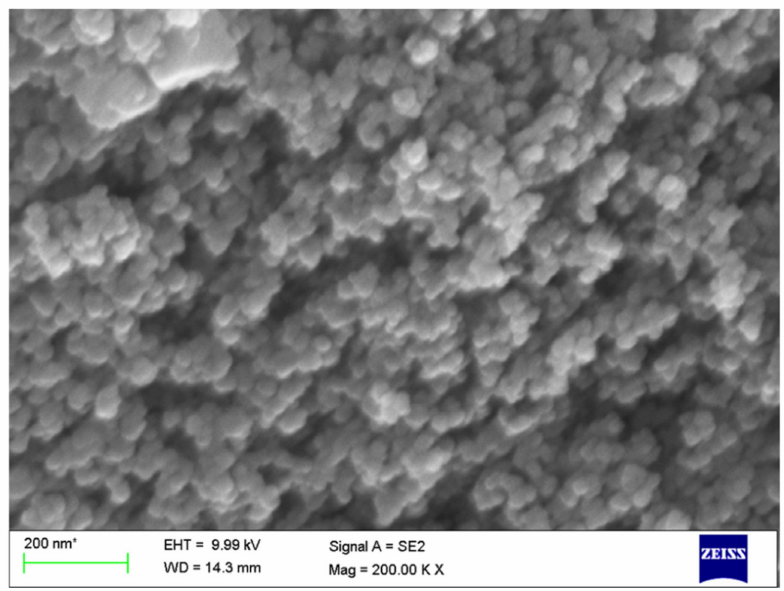
Figure 6. SEM images of as-obtained L-ZnONPs depicting